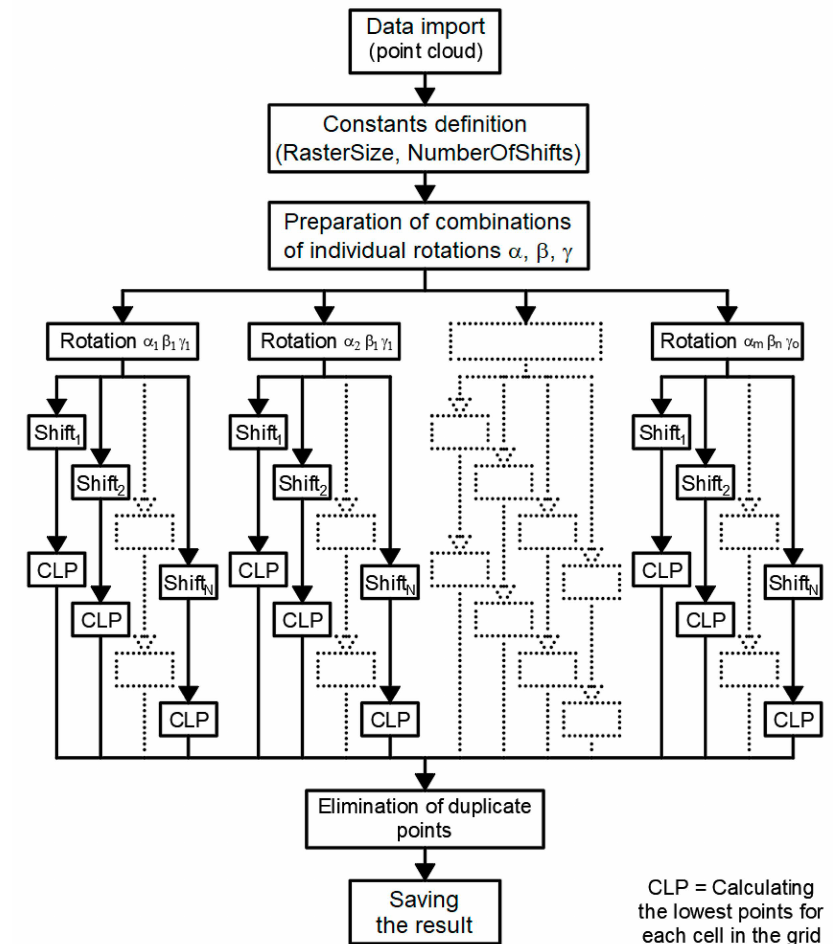
Figure A1. MDSR Algorithm